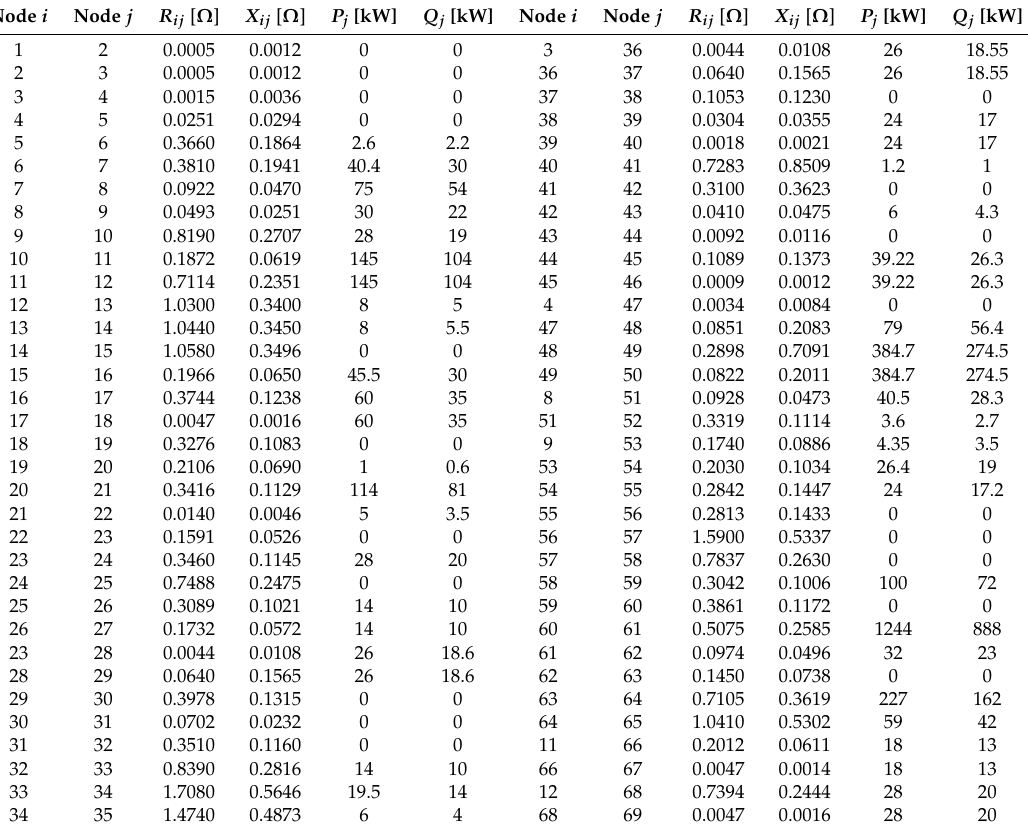
Table A2. Electrical parameters of the 69-node test